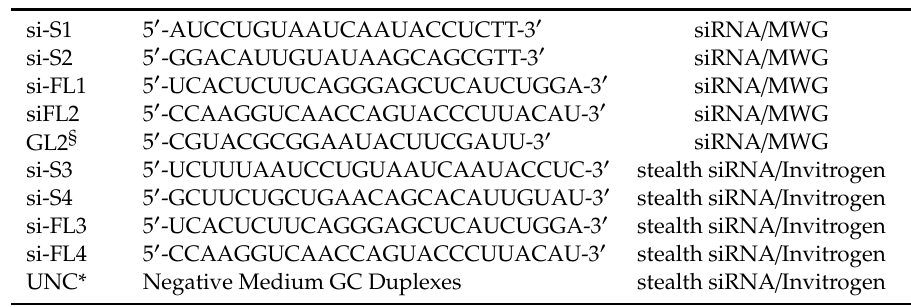
Table 2. HIPK2 isoform specific